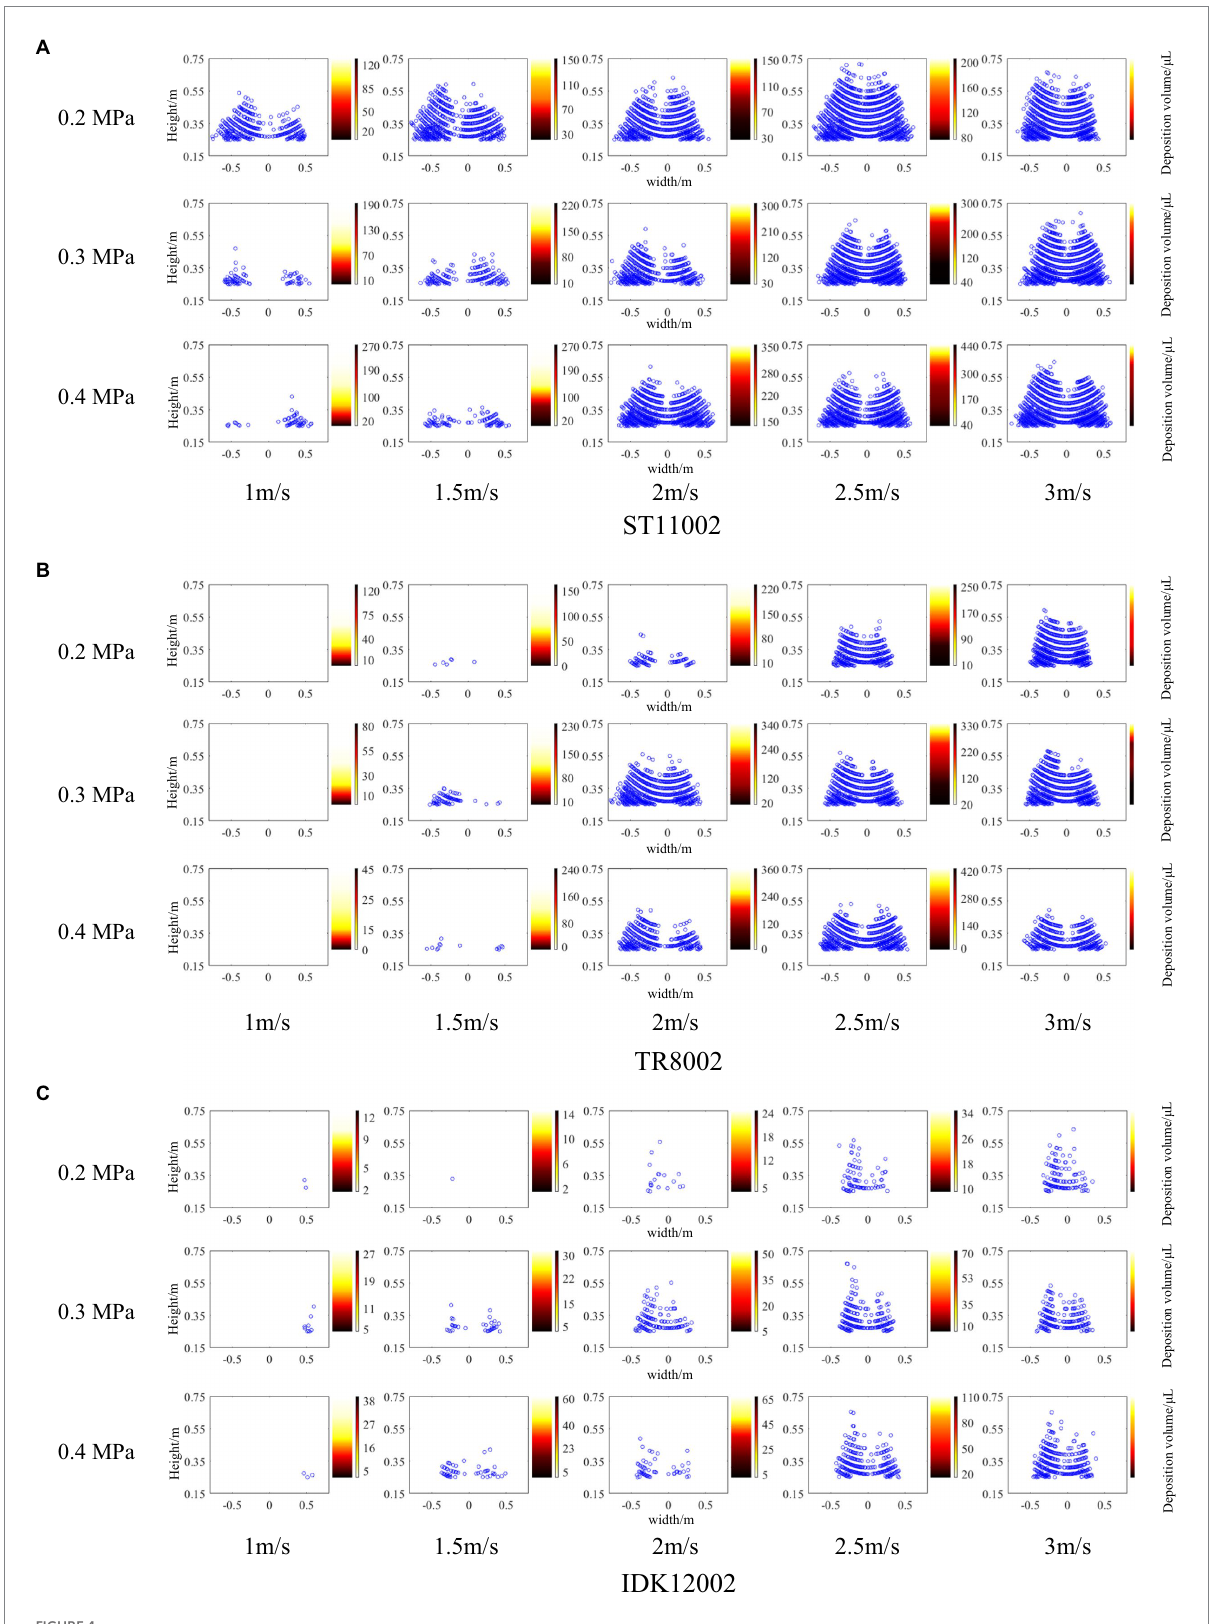
FIGURE 4 Drift points scanned by the LiDAR sensor (left of each panel) and drift deposition captured by passive collectors (right of each panel) for the three nozzles. In the strip plot for each combination, darker colors represent greater drift deposition. (A) ST11002. (B) TR8002. (C)